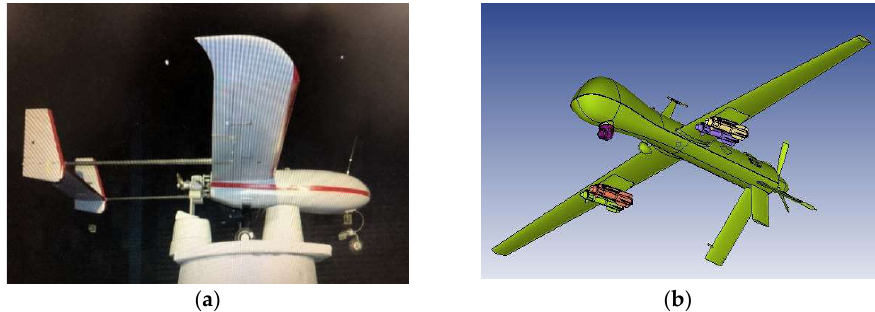
Figure 4. The two kinds of UAVs studied in this paper. ( a ) “Frontier” UAV; ( b ) “MQ-1” UAV.